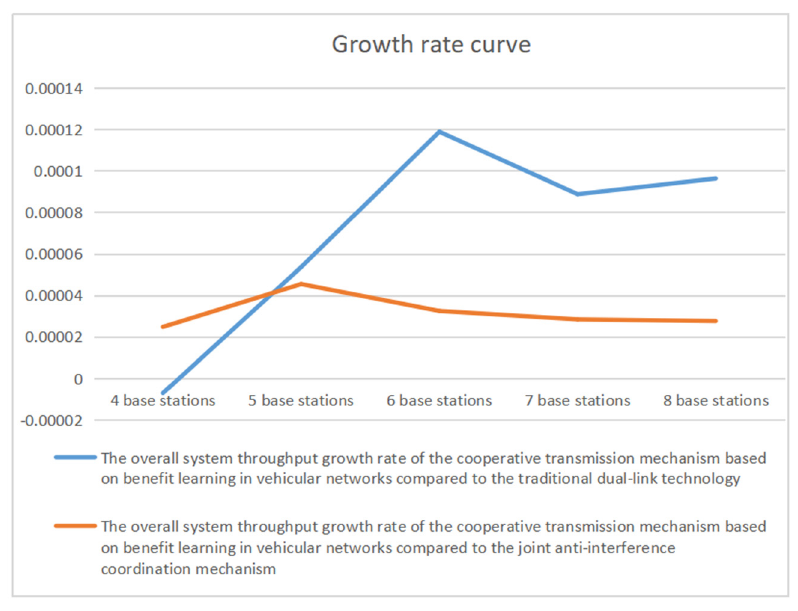
Figure 7. Growth rate curve.